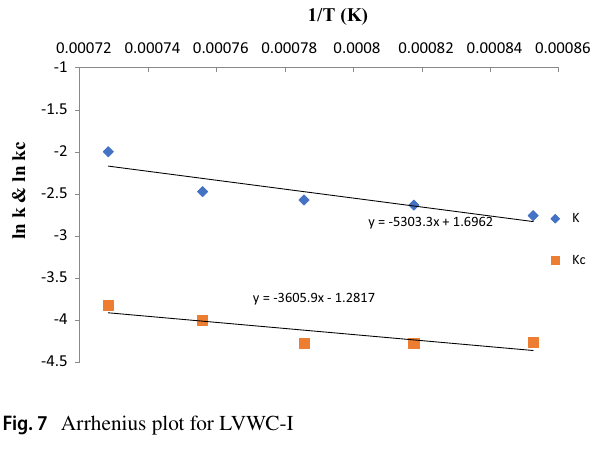
Fig. 7 Arrhenius plot for LVWC-I